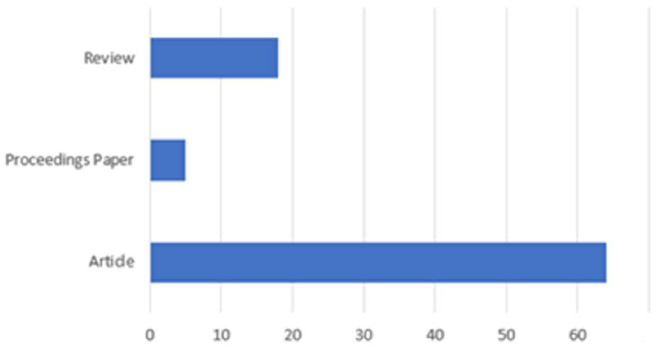
Figure 6. Selected paper types.